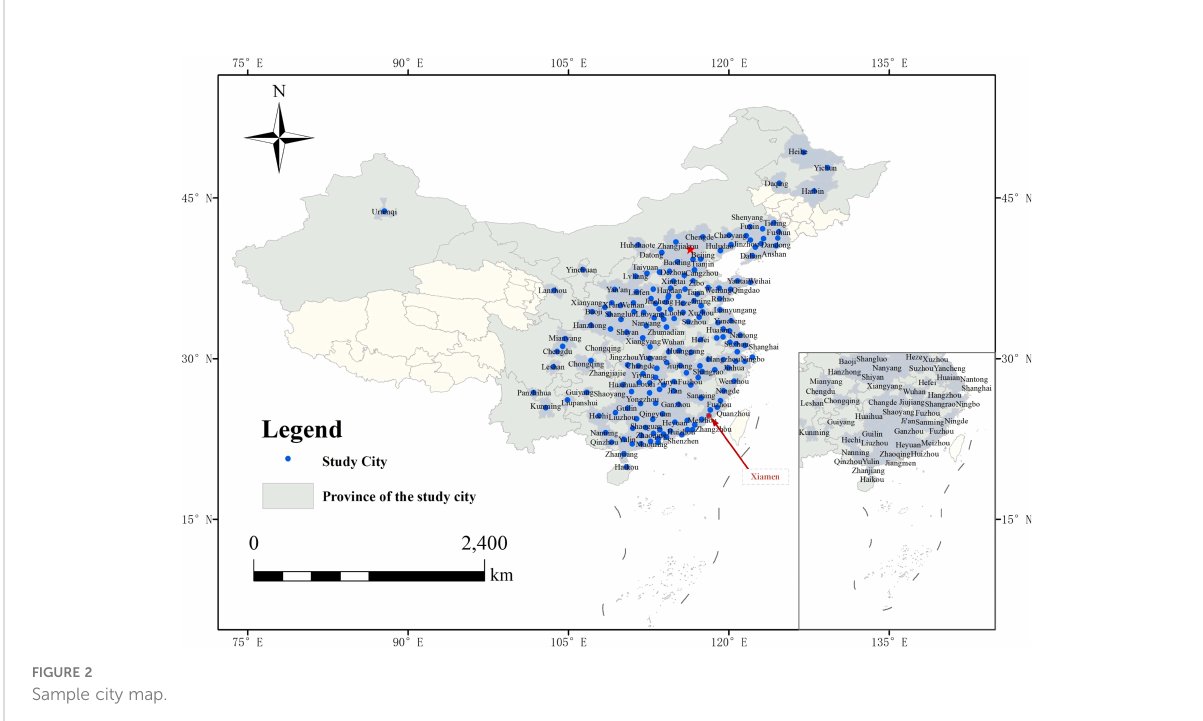
FIGURE 2 Sample city